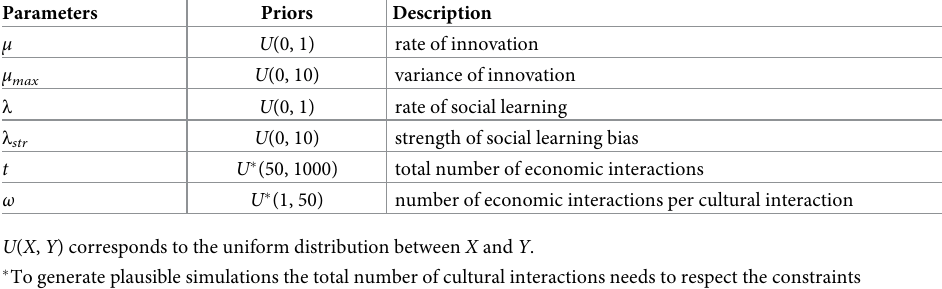
U (0, 10) U � (50, 1000) ω U � (1, 50) number of economic interactions per cultural interaction U ( X , Y ) corresponds to the uniform distribution between X and Y . � To generate plausible simulations the total number of cultural interactions needs to respect the constraints described in the text, thus some combinations of t and ω have to be